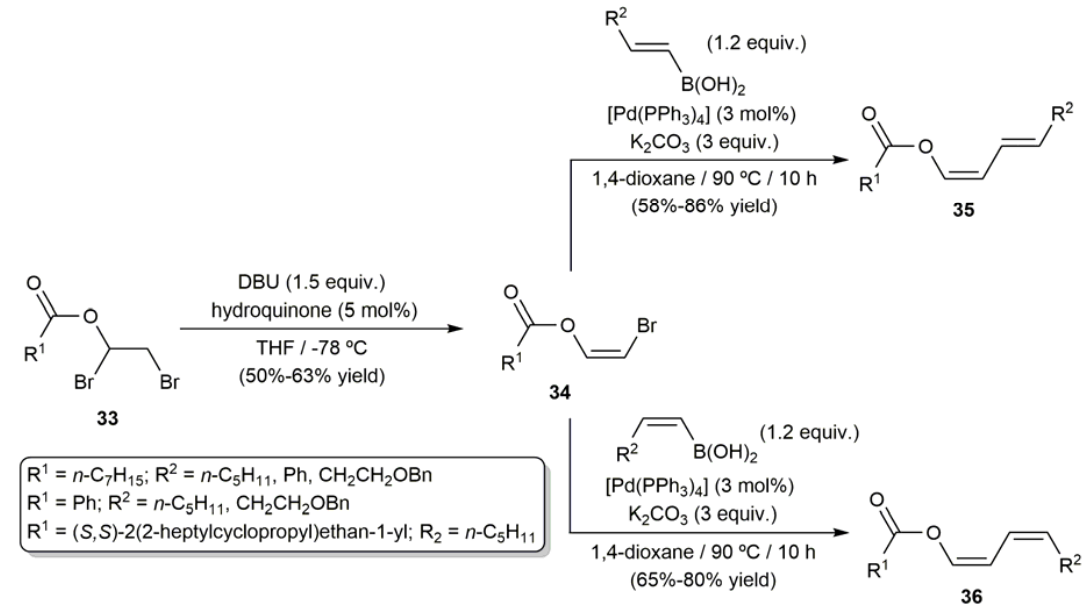
Figure 5. Structure of the tetrasubstituted olefins 37 – 40 . Probably, the reactions of β ‐ haloenol esters most widely studied to date are the palladium ‐ catalyzed Sonogashira ‐ type couplings with terminal alkynes [30,54,60,71,76–78]. In this regard, a large number of ( Z ) ‐ and ( E ) ‐ β ‐ haloenol esters (both chlorides, bromides and iodides) have been successfully coupled with alipahic and aromatic alkynes, 1,3 ‐ enynes or propargylic alcohols to generate the corresponding enynyl ester products in high yields and with complete preservation of the C=C bond stereochemistry of the starting olefins (the results obtained in references [60], [76] and [77] are depicted in Scheme 19).